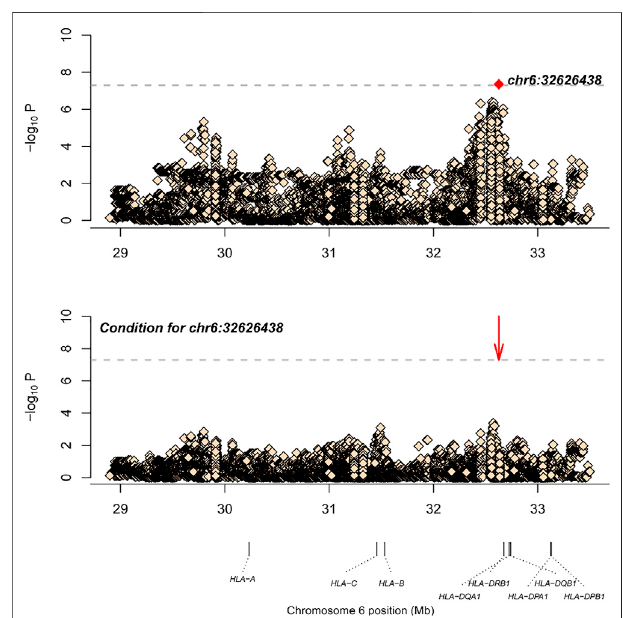
FIGURE 2 | The results of M-SM disease association analysis. The abscissarepresentsgenomicloci,andtheordinaterepresents-log10(p)ofthe association analysis for each locus. The horizontal line represents the signi fi cance threshold p = 1.47 × 10 – 6 . The red dots in each panel represent the sites used for conditional analysis (chr6: